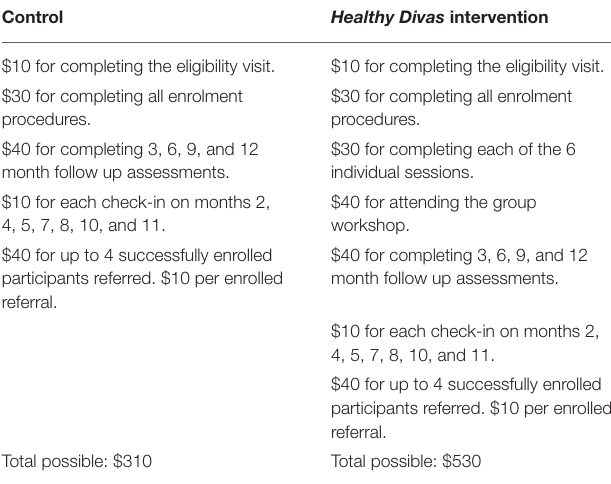
TABLE 6 | Healthy Divas incentive schedule.